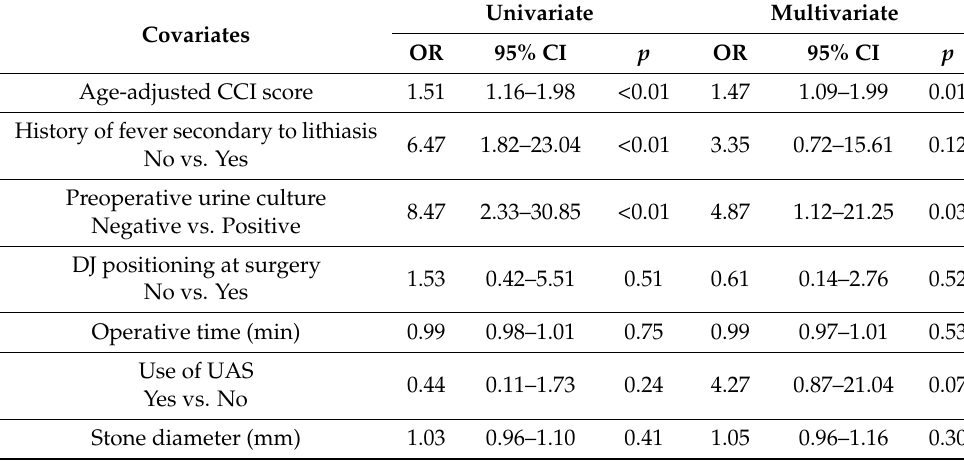
Table 4. Univariable and multivariable logistic regression analyses predicting postoperative urosepsis.